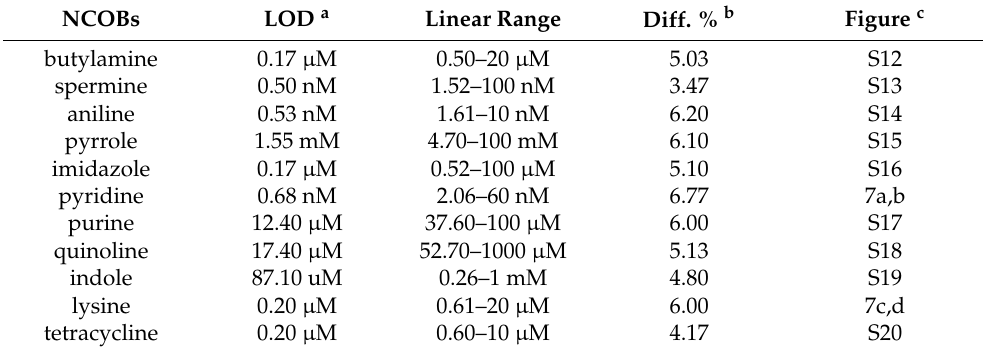
Table 3. Key parameters for the detection of NCOBs using PL-based, C-dots derived sensing assays. NCOBs LOD a Linear